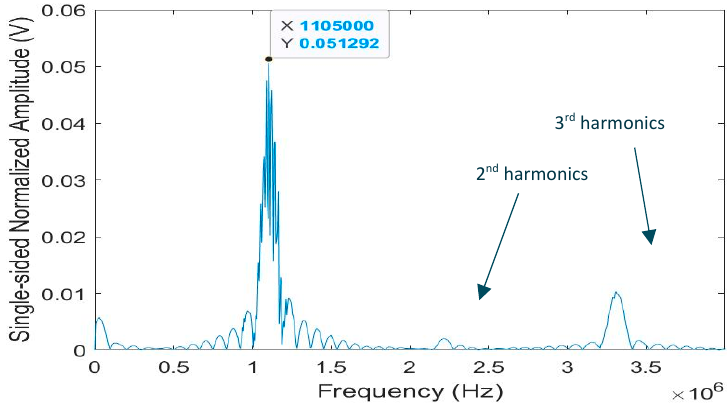
Figure 19. Frequency spectrum for one of the guided modes. The presence of harmonics is also